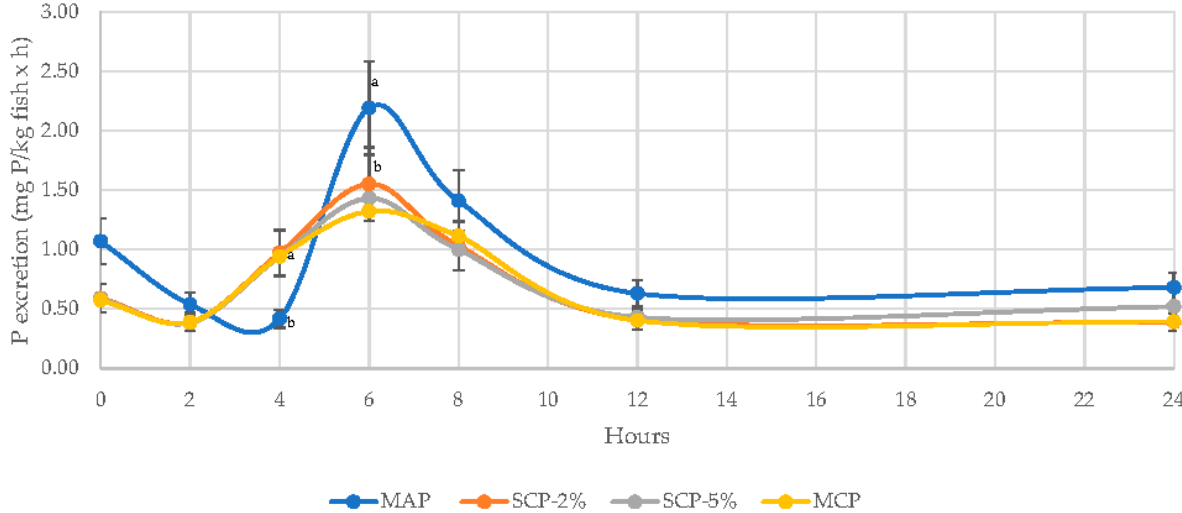
Figure 3. Daily pattern of soluble total ammoniacal N excretion rate (expressed in mg of N-NH 4+ per kg of fish biomass and hour) of rainbow trout fed four inorganic P sources. Each point represents the average (±SE) of four tanks. Different superscripts indicate statistically significant differences with p < 0.05. A Newman–Keuls test was used to compare the means. The amount of N excretion was determined based on N-TAN concentration in water every two hours after feeding over a 24-h period.